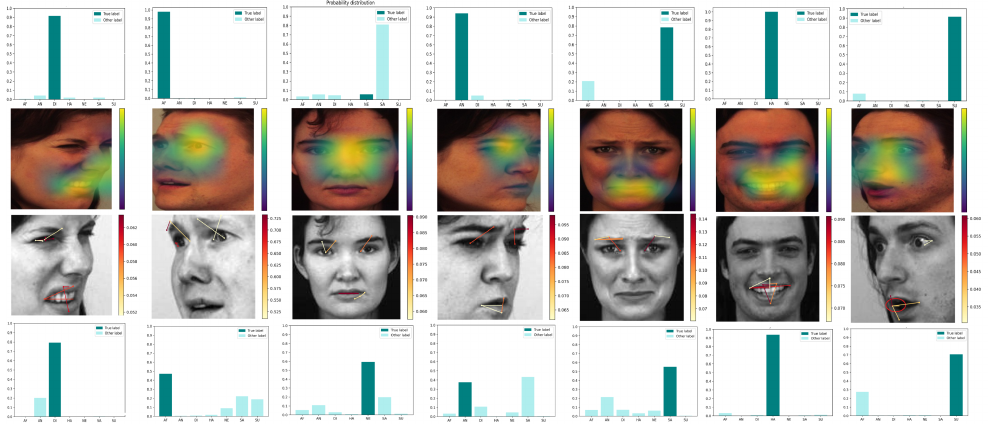
Figure 4. Example explanations for the CNN using Grad-CAM (second row) and DNN (third row) displaying all seven emotions. The images are the same and have the following codes: AF07DIHR, AM11AFHL, AF04NES, AF03ANHR, AF01SAS, AM01HAS, BM03SUHL, respectively. The top and bottom row give the corresponding probability distributions for the images